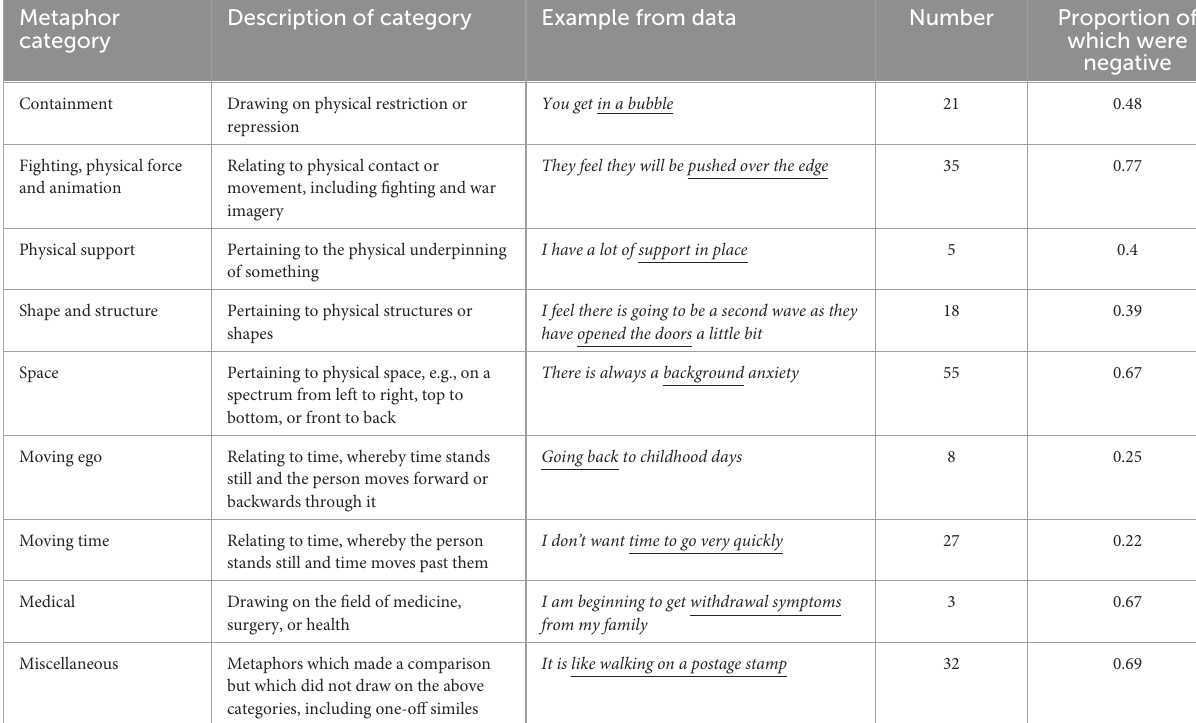
TABLE 2 Broad categories of metaphor identified in the transcripts. Metaphor